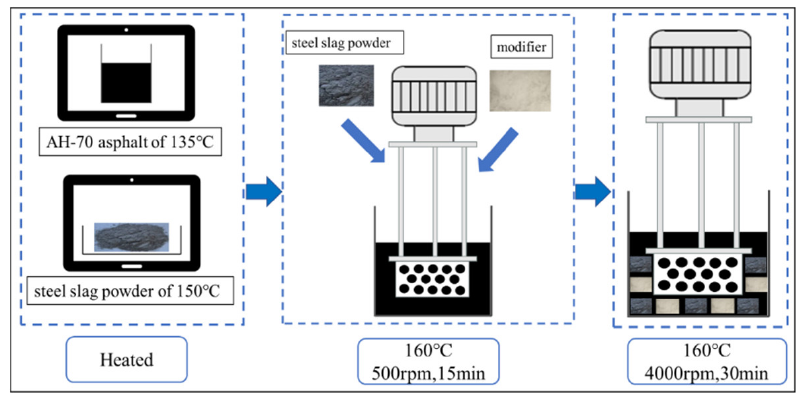
Figure 3. The preparation of steel-slag-powder-modified asphalt mortar.